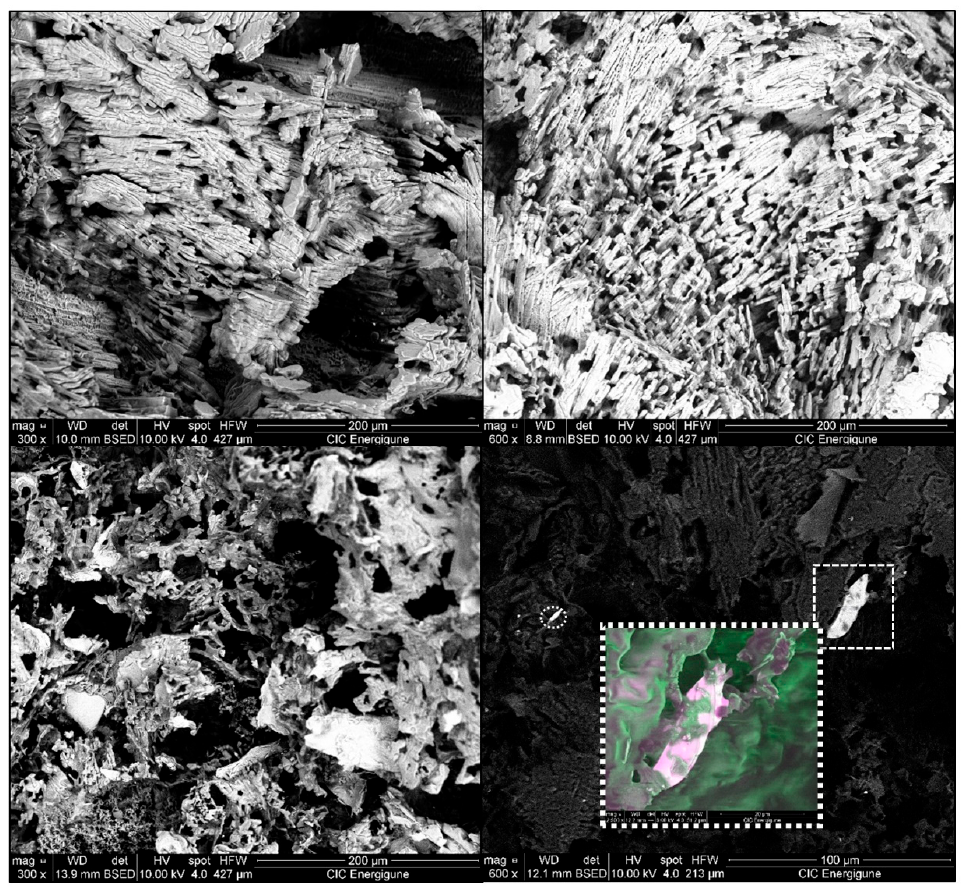
Figure 6. SEM images of HG 40 (top left corner), BM 40 (top right corner) and EG 40 (bottom pictures).